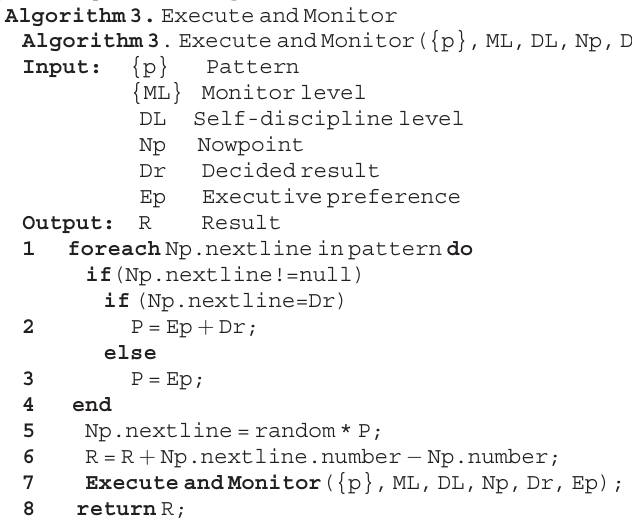
Algorithm 3. Execute and Monitor Algorithm 3 . Execute and Monitor({p}, ML, DL, Np, Dr,